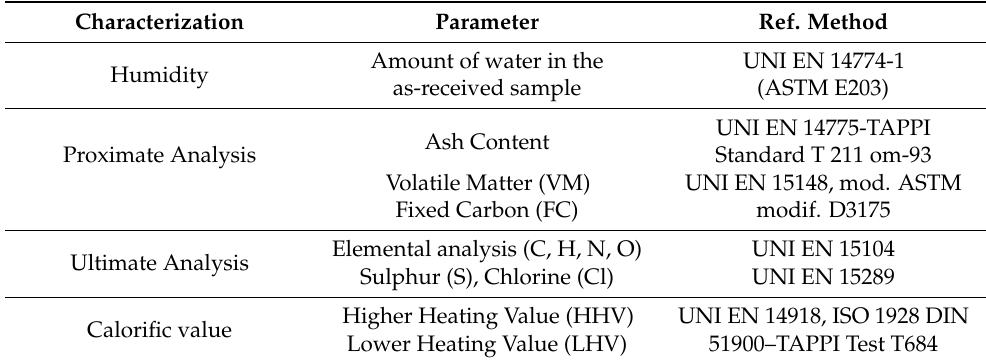
Table 2. Methods of reference for the characterizations of the hazelnut shells.